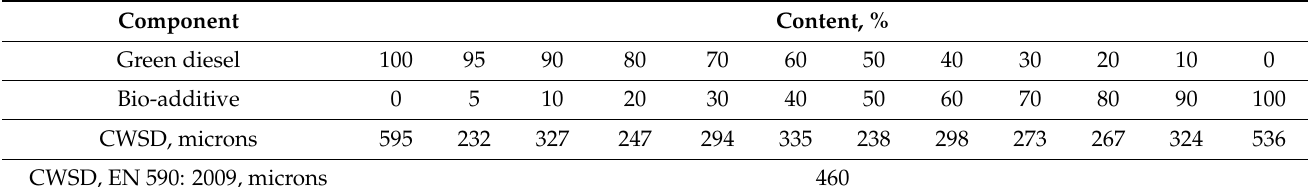
Table 5. Dependence of lubricity on the content of bio-additives in the green diesel fuel.